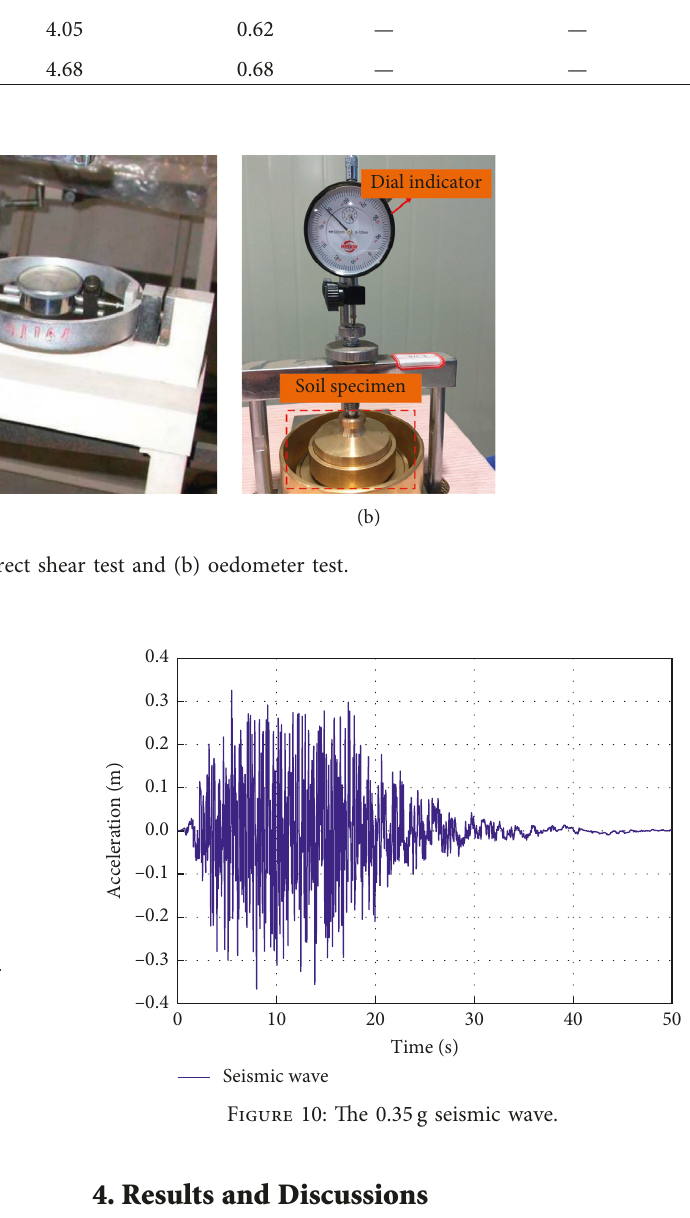
Reserved hole position for rock-socketed pile foundation by using PVC pipe Figure 9: Preparation of model bedrock.